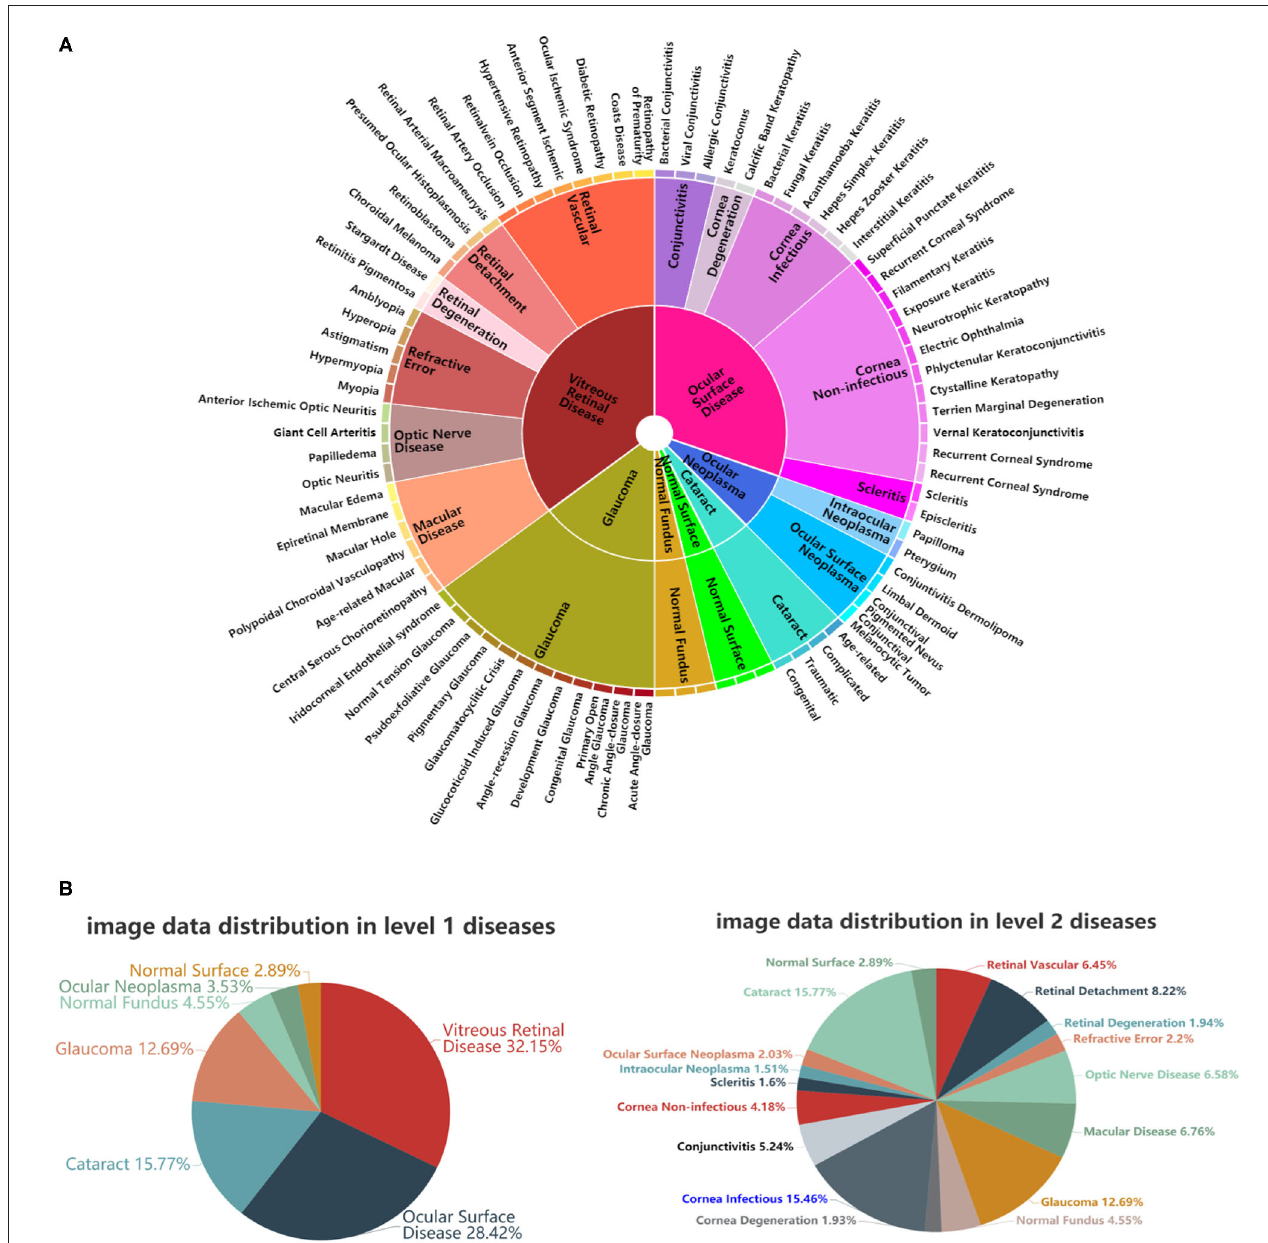
FIGURE 2 | A schematic illustration of the predefined eye disease taxonomy and example test set images. (A) Pie-structured eye disease taxonomy. (B) Data distribution for the first two levels of diseases.